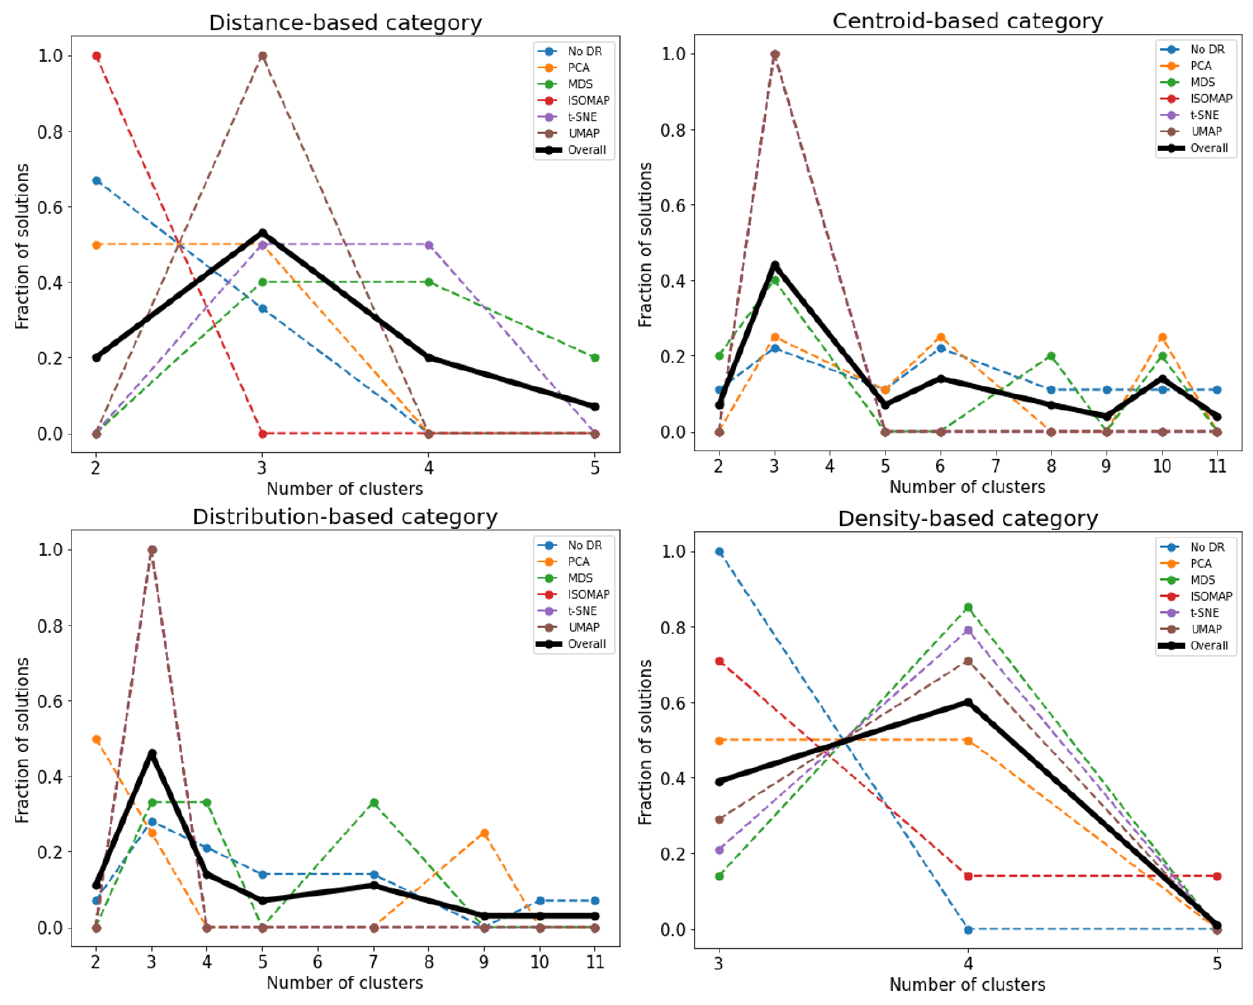
Figure 4. Fraction of solutions representing found number of clusters in the wine data set for each DR